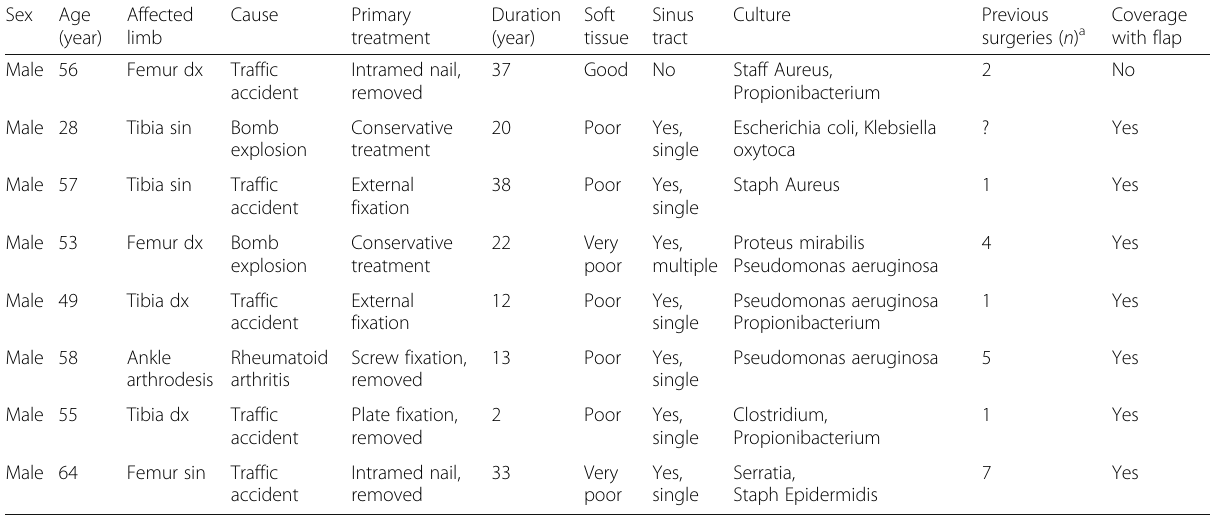
Table 1 Characteristics of eight patients with posttraumatic ( n = 7) or postoperative ( n = 1) chronic osteomyelitis